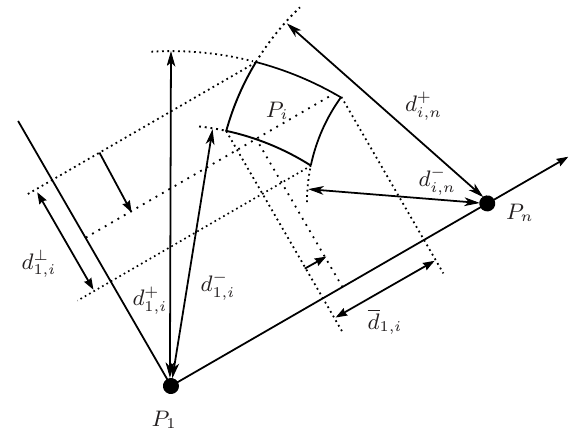
Figure 6. Possible location of P i for the given ranges of d 1, i and d i , n and the corresponding projections on the axis defined by P 1 P n , d 1, i , and on its orthogonal complement, d ⊥ d ⊥ can be translated into a reduction of the range of d 1, i 1, i